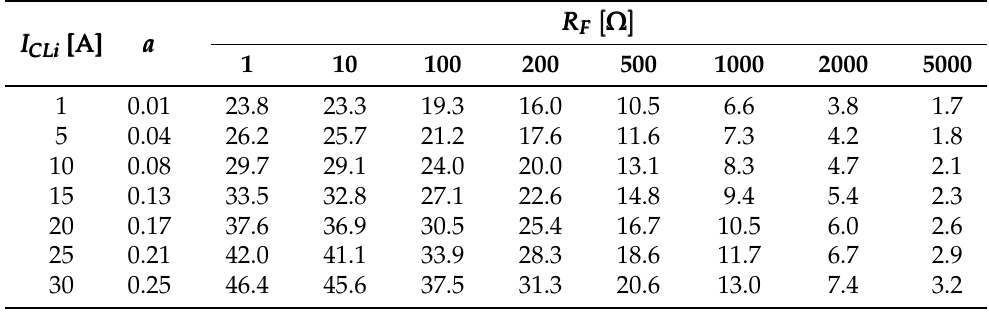
Table 3. Calculated values of the earth fault current I kb in place of the protection